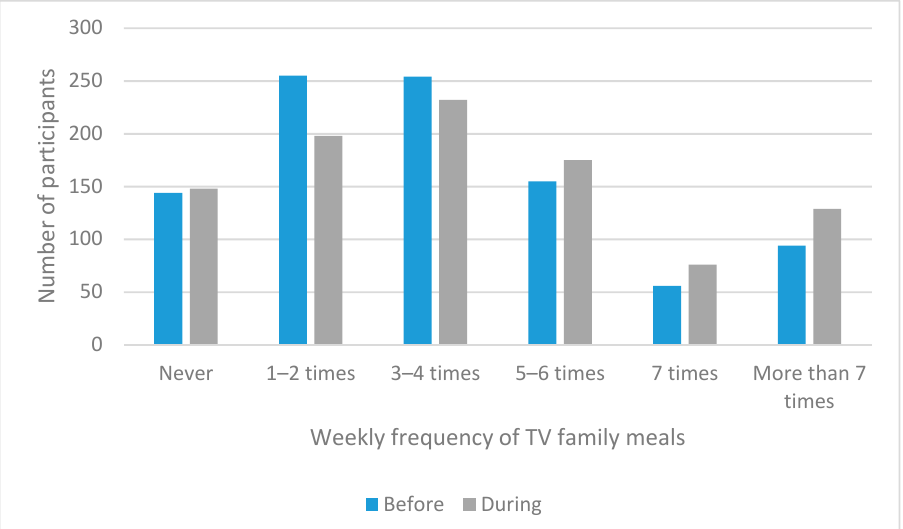
Figure 3 . Weekly frequency of consuming meals with all or most of the people in the household while watching television prior to and during the pandemic .